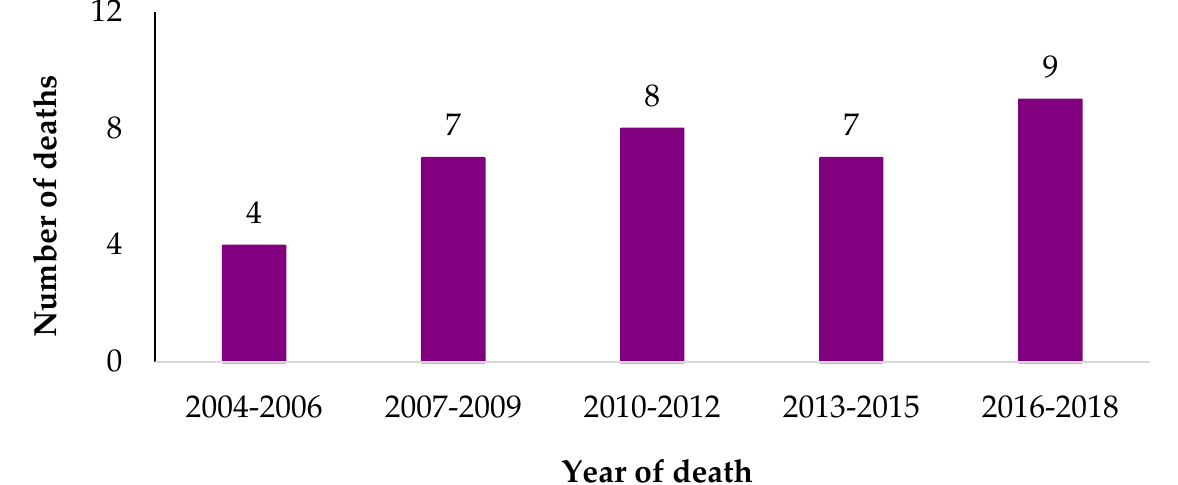
Figure 1. Number of WTCHR enrollee suicide deaths in NYC by year. WTCHR: World Trade Center Health Registry.